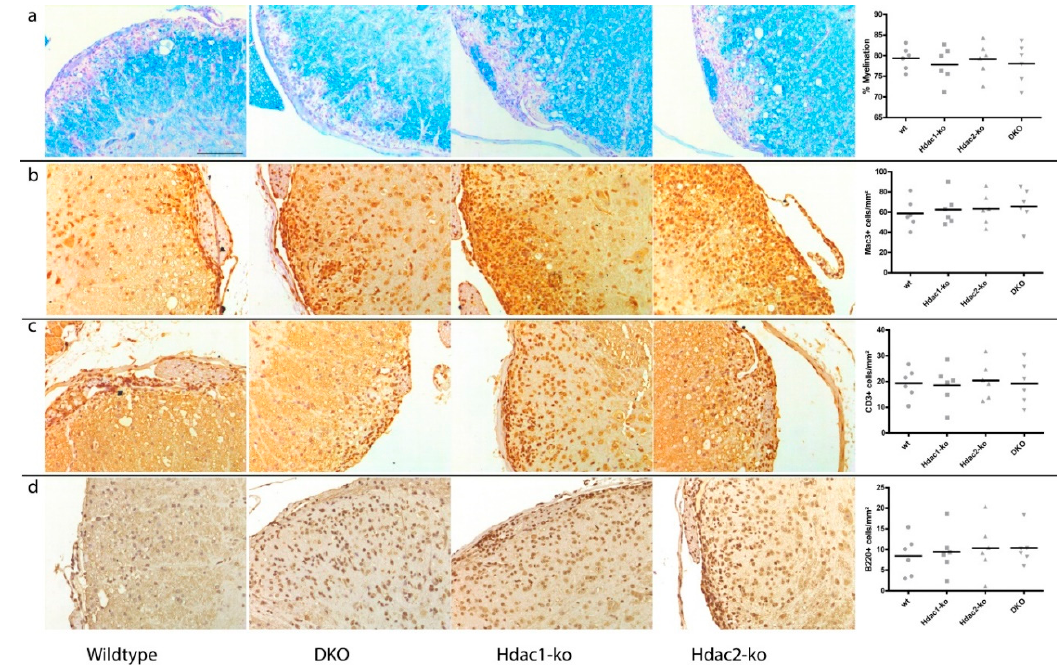
Figure 3. Higher-magnification images of histological and immunohistochemical stains and quantification of six samples for each genotype. ( a ) Myelination as identified by LFB staining; blue-stained tissue is myelinated. ( b ) Mac-3-positive macrophages/microglia in spinal cord lesions. ( c ) CD3-positive T cell and ( d ) B220-positive B cell counts. No statistically significant changes were found in either analysis. Scale bar = 100 μ m; all images have the same scaling.